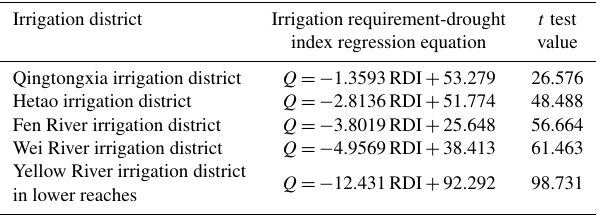
Table 6. Drought index regression between irrigation requirement and RDI of main irrigation districts of Yellow